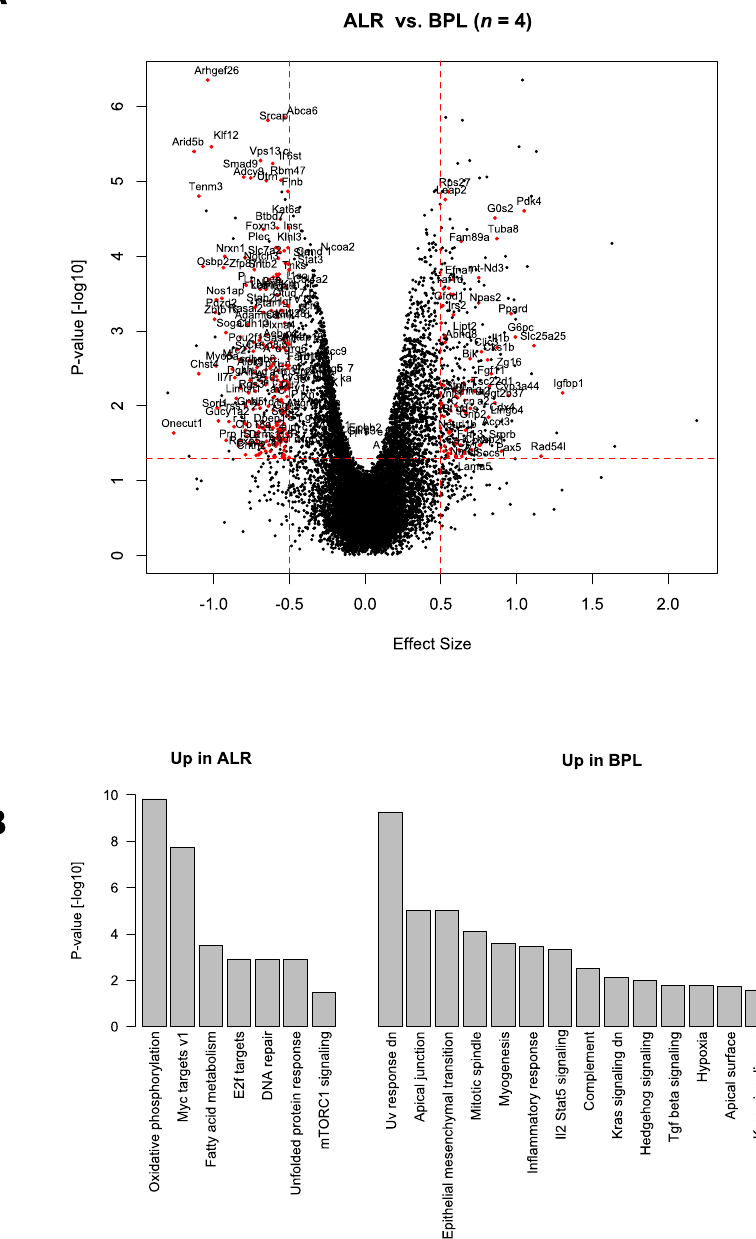
Figure 4. Transcriptome analysis revealed mitochondrial and age-related pathways were affected by the mt-Nd2 mutation. ( A ) Differentially expressed genes between B6-mt ALR and B6-mt BPL mice. The volcano plot shows the e ff ect size versus the -log10 p -value of di ff erentially regulated genes. Genes with the expression levels p < 0.01 were plotted in red. n = 4 / strain, female. BPL: B6-mt BPL ; ALR: B6-mt ALR . ( B ) Hallmark pathway analysis show the pathways upregulated in B6-mt ALR mice (left) and upregulated in B6-mt BPL mice